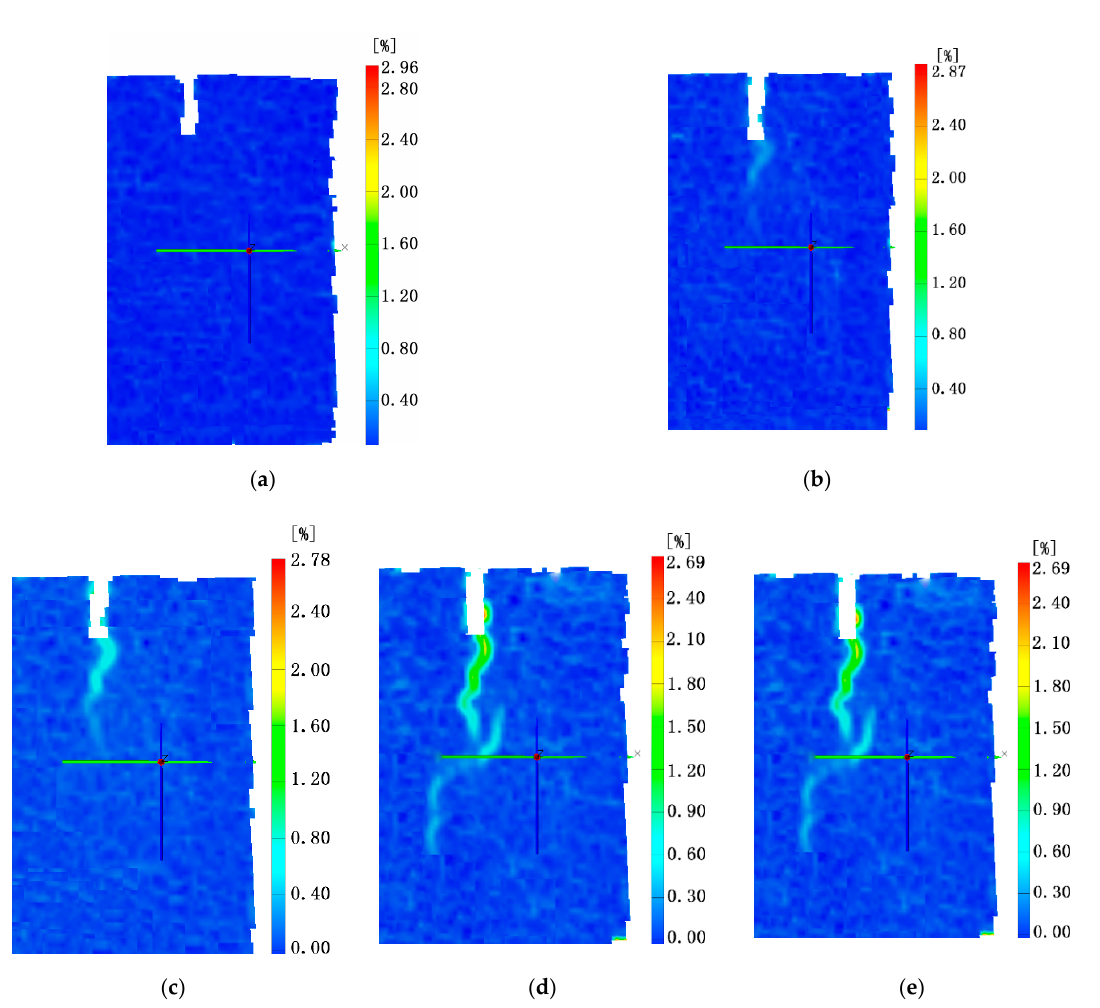
Figure 8. Surface strain distribution during crack frost-heave propagation. ( a ) The process of temperature equilibrium, stage 1; ( b ) micro-crack formation, stage 2; ( c ) obvious crack, stage t3; ( d ) freezing force release, stage 4; ( e ) frost heave completed, stage